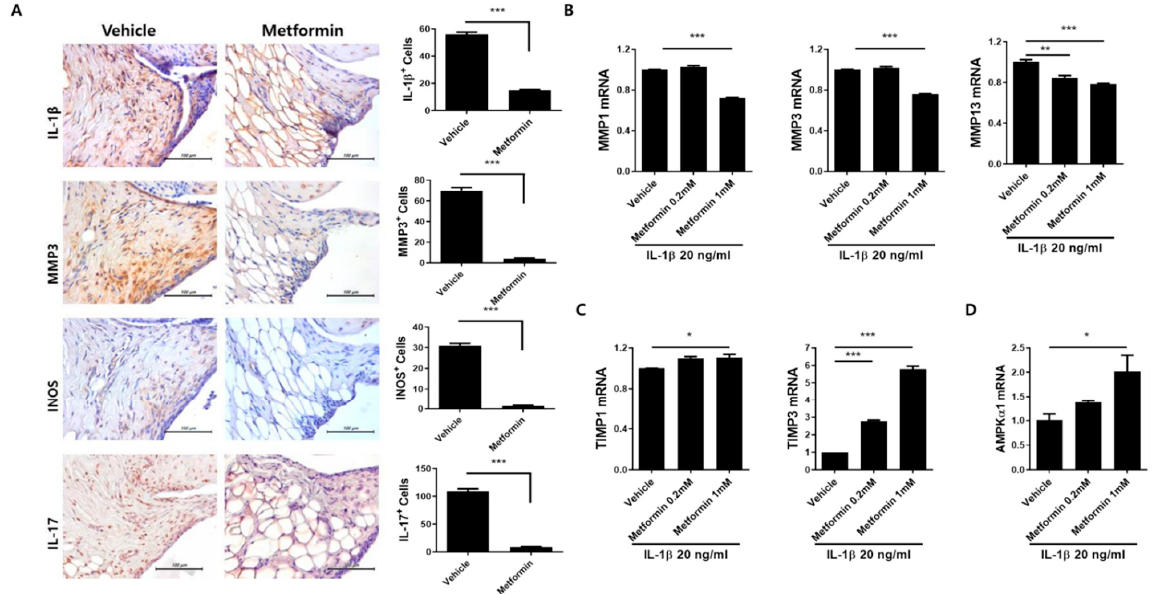
Figure 3. Expression of Inflammatory mediators following metformin administration. The rats were injected with 3 mg of MIA. After OA induction, the rats were administrated with metformin 100 mg/kg (N = 6 animals per group). The OA